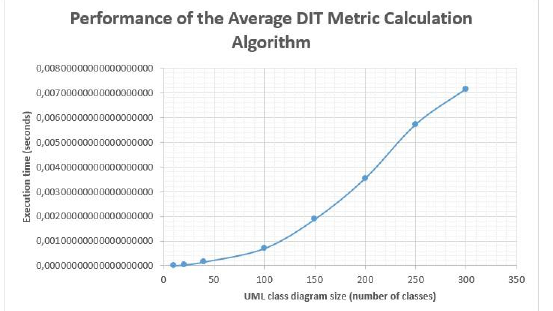
Fig. 6. Performance of the Average NOC Metric Calculation Algorithm